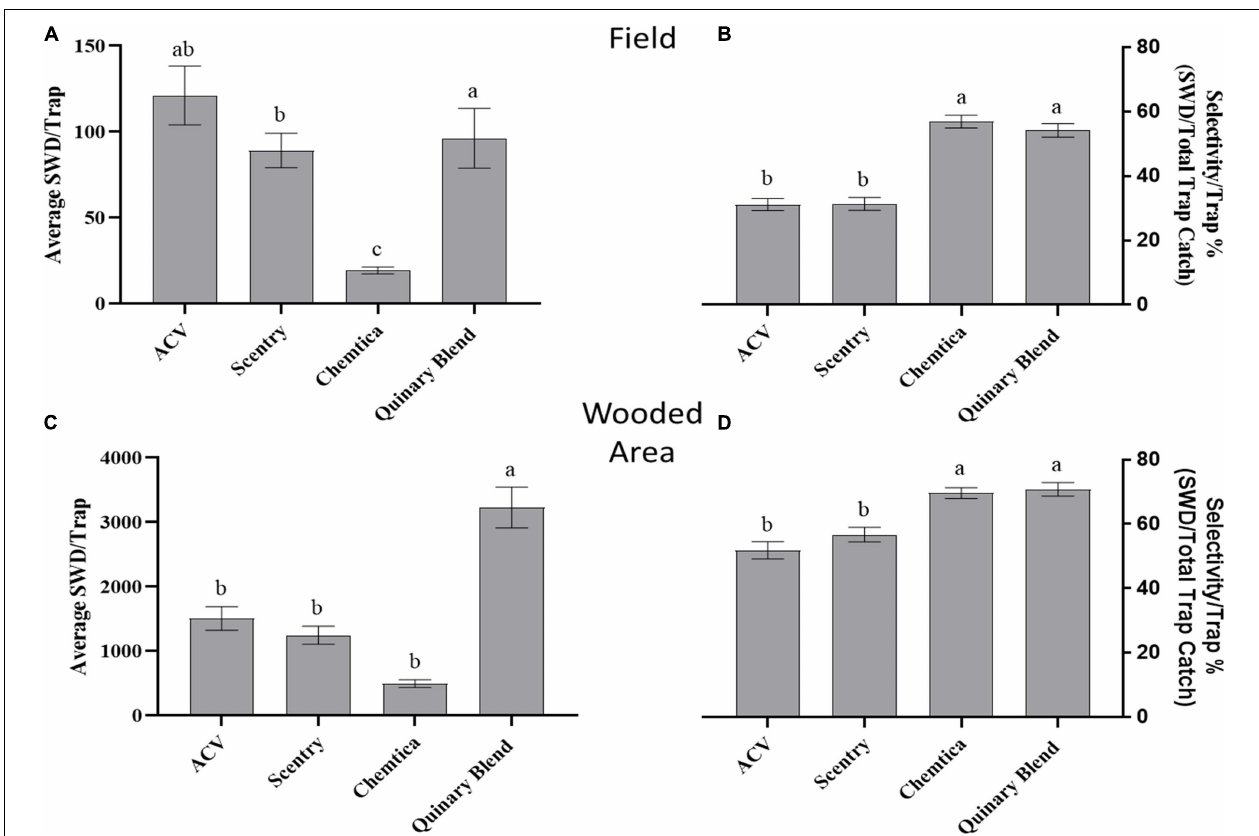
FIGURE 4 | Average SWD capture per trap and overall selectivity over 8 weeks of trapping period in Maryland in a raspberry field and nearby wooded area in 2017 (July 19 to August 9) by traps baited with ACV (apple cider vinegar), Scentry dispenser, ChemTica dispenser, and a quinary dispenser. (A) average capture in the raspberry field in 2017 ( N = 532, df = 3, 528, F = 14.66, and P < 0.001); (B) selectivity in the wooded area in 2017 ( N = 531, df = 3, 527, F = 46.95, and P < 0.001); (C) average capture in the wooded area in 2017 ( N = 511, df = 3, 507, F = 17.62, and P < 0.0001); and (D) selectivity in the wooded area in 2017 ( N = 498, df = 3, 494, F = 18.48, and P < 0.0001). Means separated by one-way ANOVA with a Tukey’s post-test. Error bars represent standard error. Different letters above bars in each subfigure indicate significant differences at α = 0.05. Data represented are